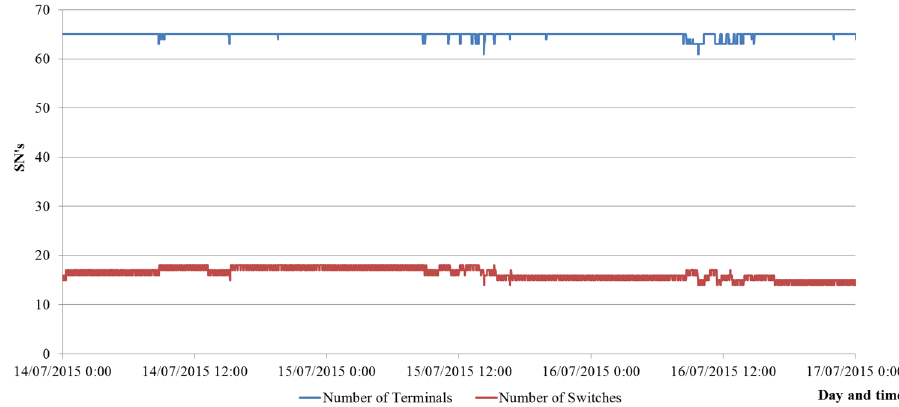
Figure 9. Topology SNs connected to the BN; terminals and switches) evolution of a PLC subnetwork.